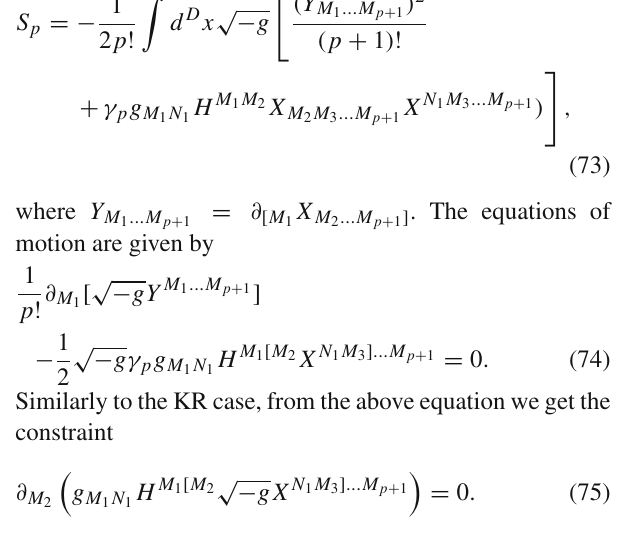
Fig. 9 Transmission coefficient in kink scenario for KR field as function of E = m 2